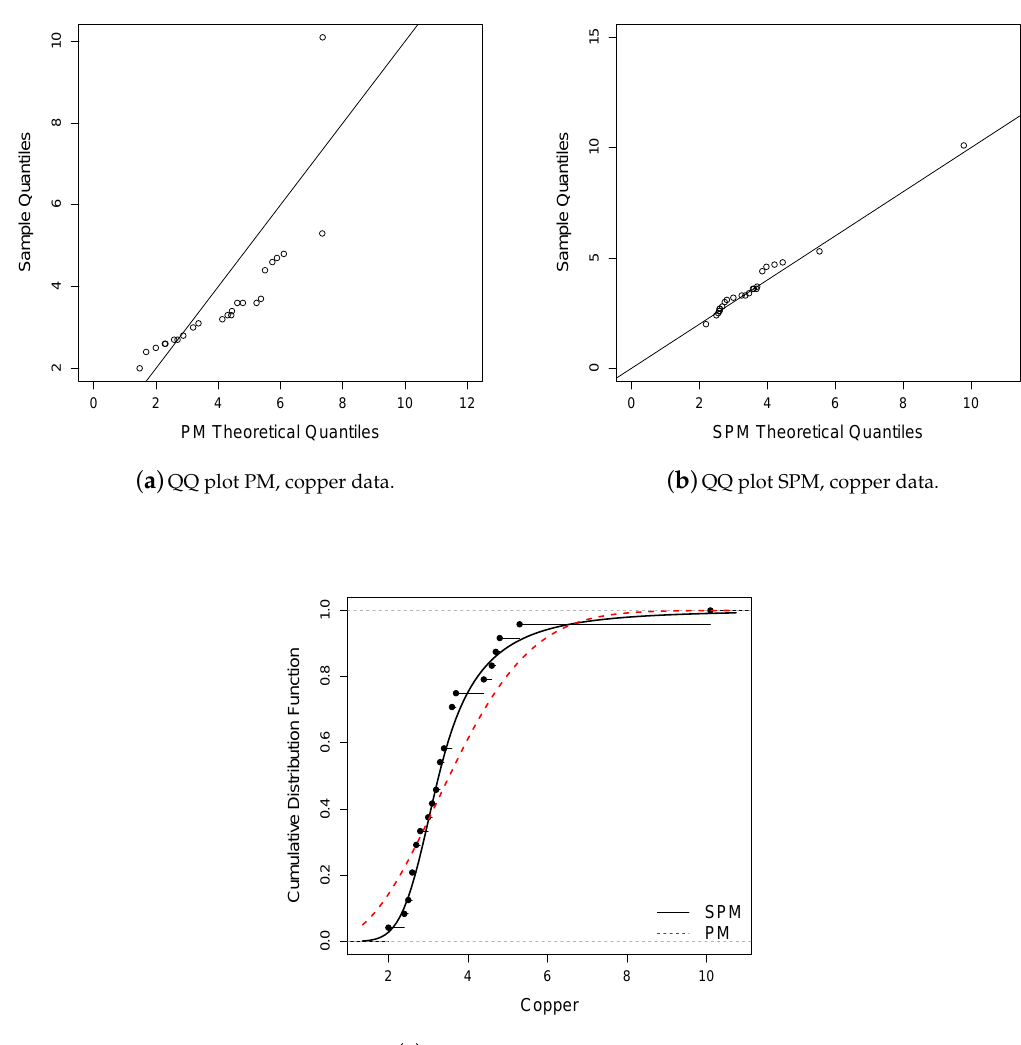
( c ) Empirical plot, copper data. Figure 8. QQ and empirical plot, copper